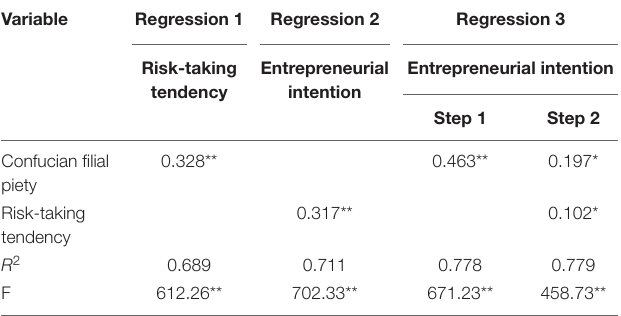
TABLE 8 | Mediation role of risk-taking